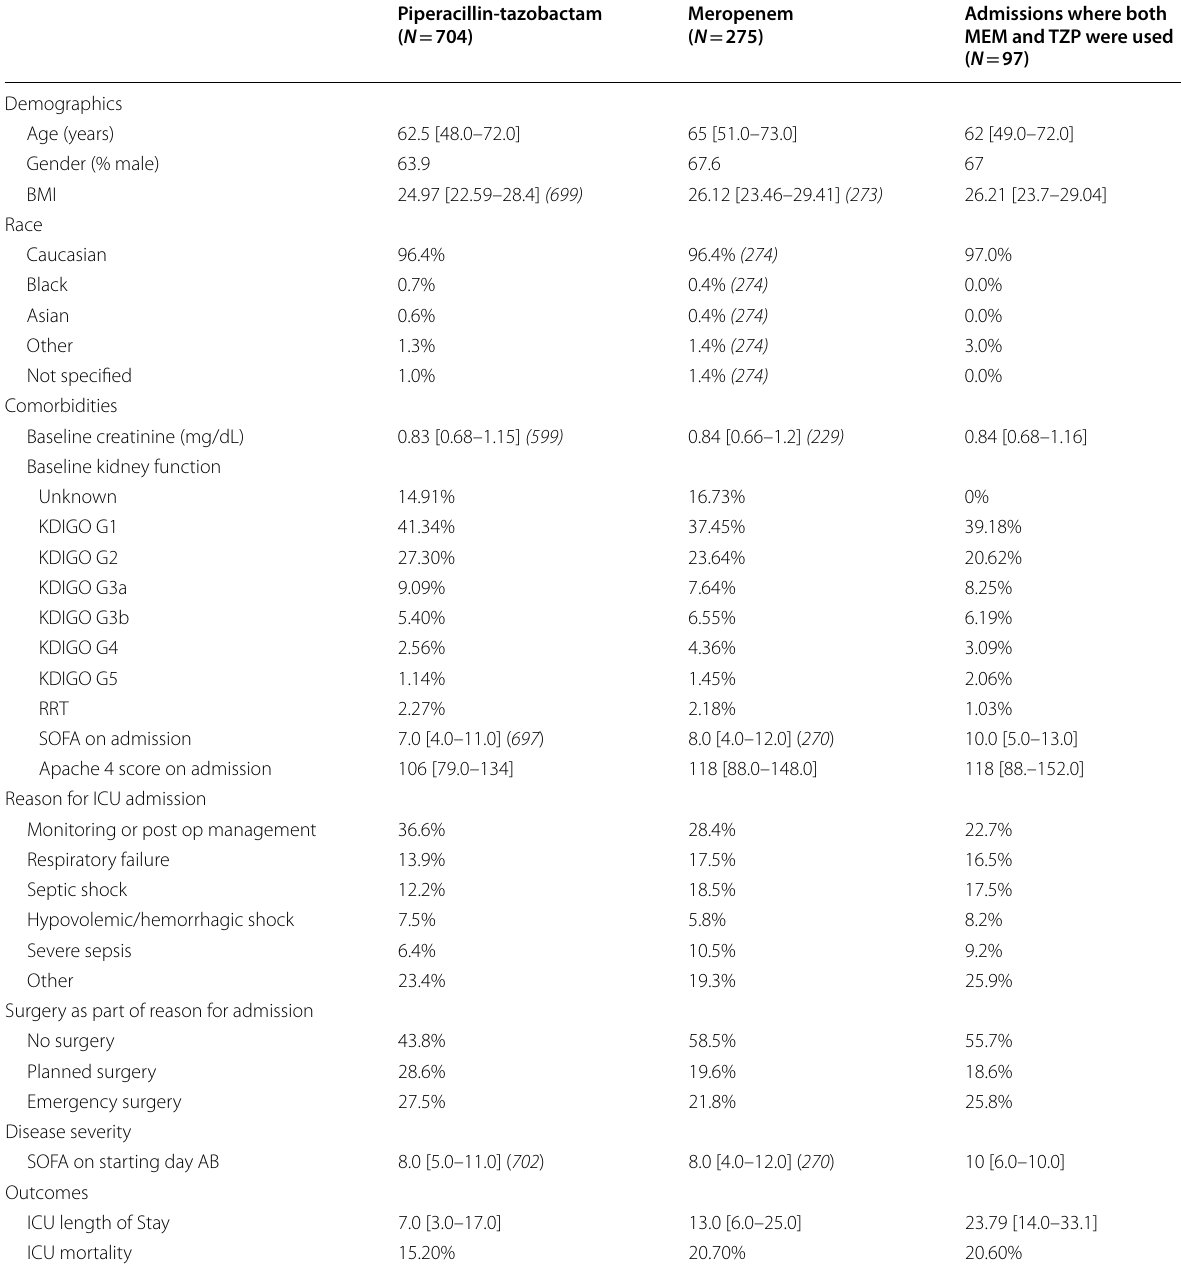
Table 2 Admission baseline